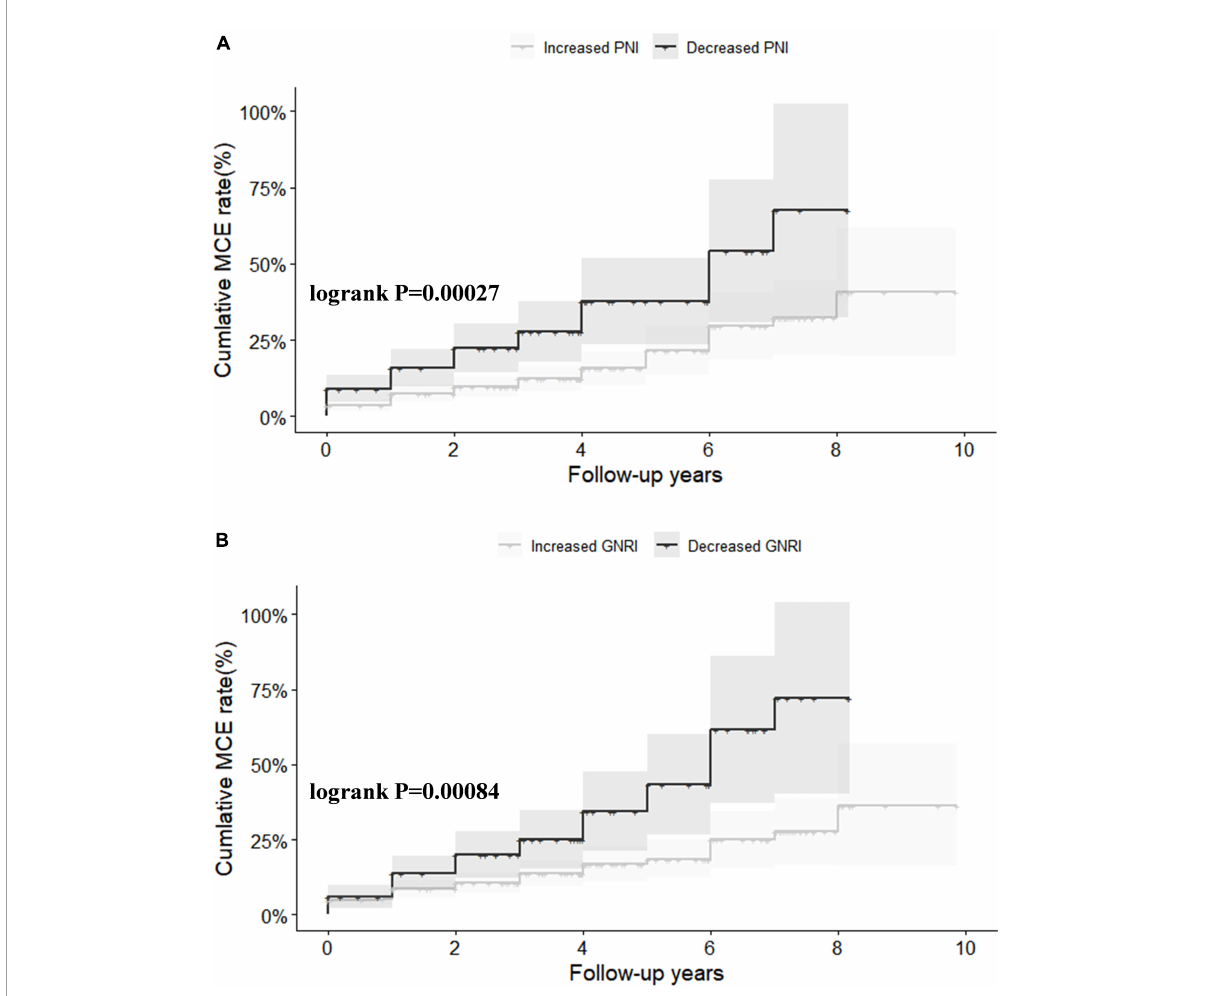
FIGURE1 Kaplan–Meier survival analysis for major adverse cardiovascular event (MCE) stratified by (cid:49) PNI (A) and (cid:49) GNRI (B) . PNI, prognostic nutritional index; GNRI, geriatric nutritional risk index.